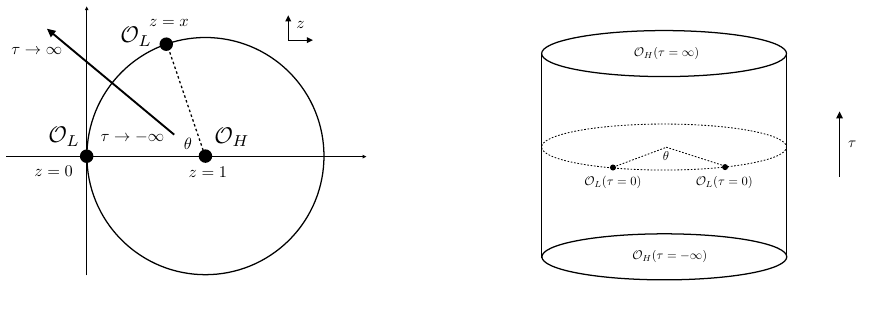
Figure 10 . Conformal mapping from the monodrompy problem (left) to a scattering problem